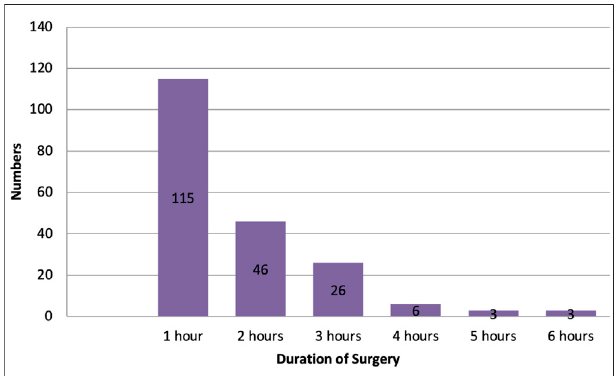
FIGURE 1 | Duration of surgeries among the study